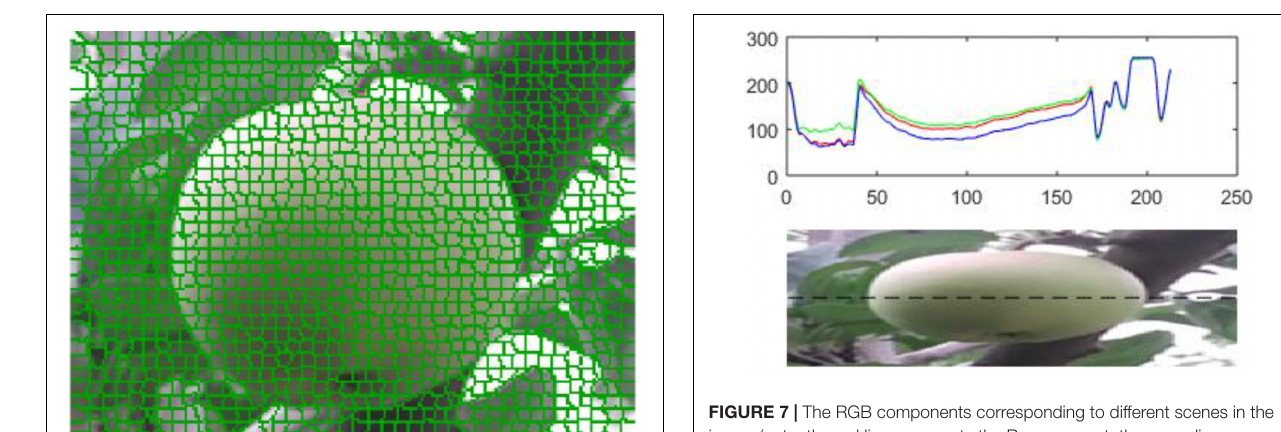
FIGURE 7 | The RGB components corresponding to different scenes in the image (note: the red line represents the R component; the green line represents the G component; the blue line is the B component; the three lines are the RGB components corresponding to the pixels in the black horizontal dashed